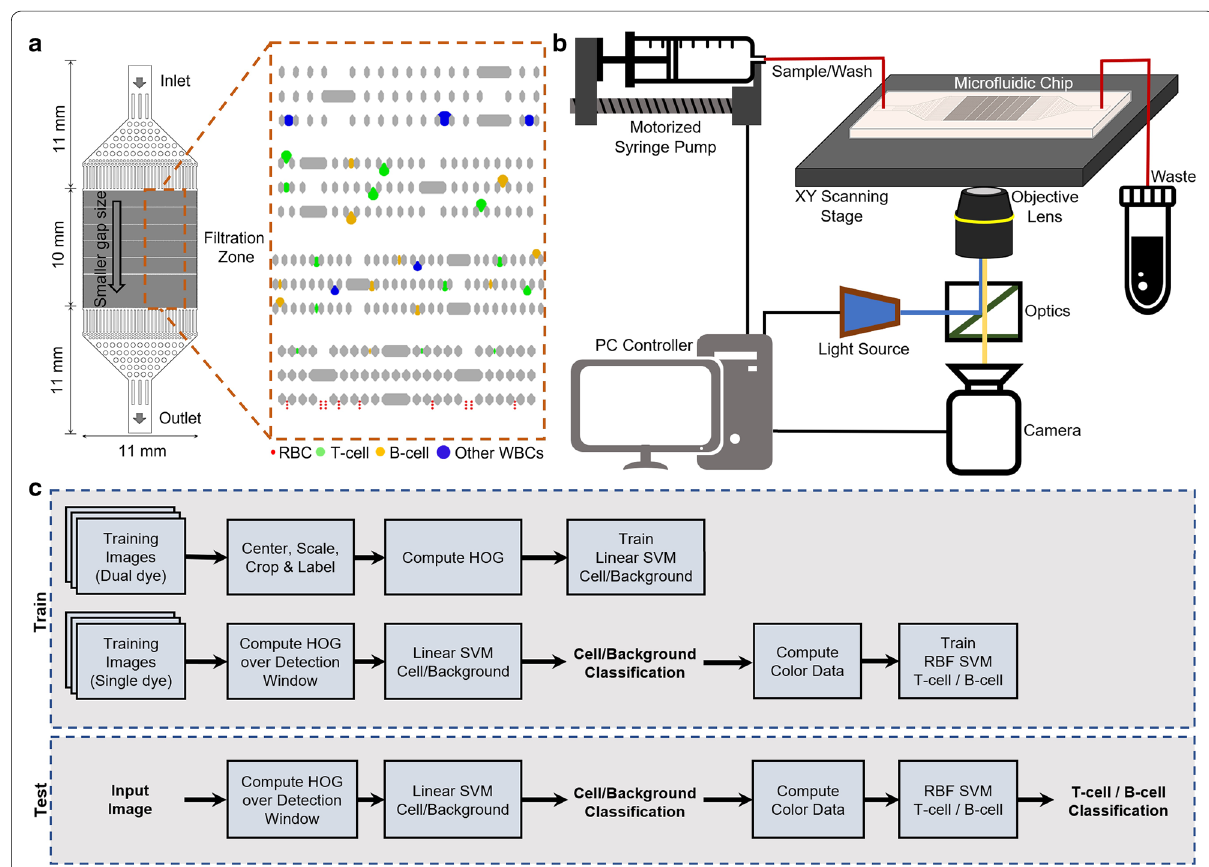
Fig. 1 Overview of the proposed system. a Design of the microfluidic chip, blood is pumped into the device via inlet port. Due to the difference in size and deformability, leukocytes will be trapped in different zones. b Experiment setup. c Block diagram of cell detection framework